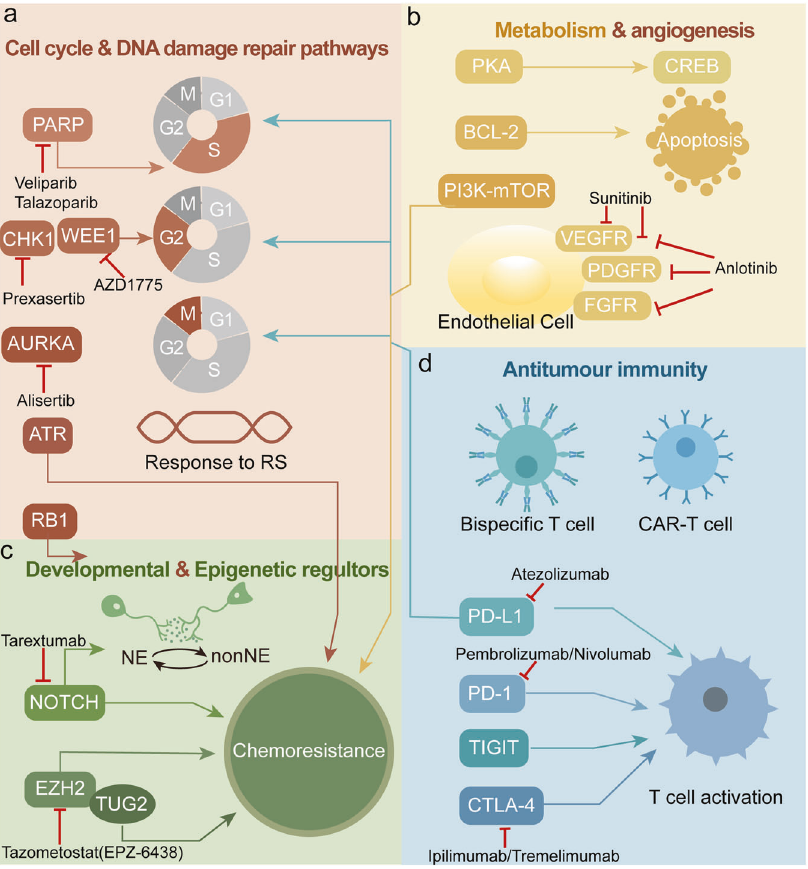
replication stress. b Metabolism and angiogenesis signaling pathways. PKA protein kinase A. c Developmental and epigenetic regulators. NE neuroendocrine, TUG taurine upregulated gene1. d Antitumour immunity. PD-1 programmed death-1, PD-L1 programmed death ligand-1, CTLA-4 cytotoxic T-lymphocyte-associated antigen 4, TIGIT T-cell immunoreceptor with immunoglobulin and ITIM